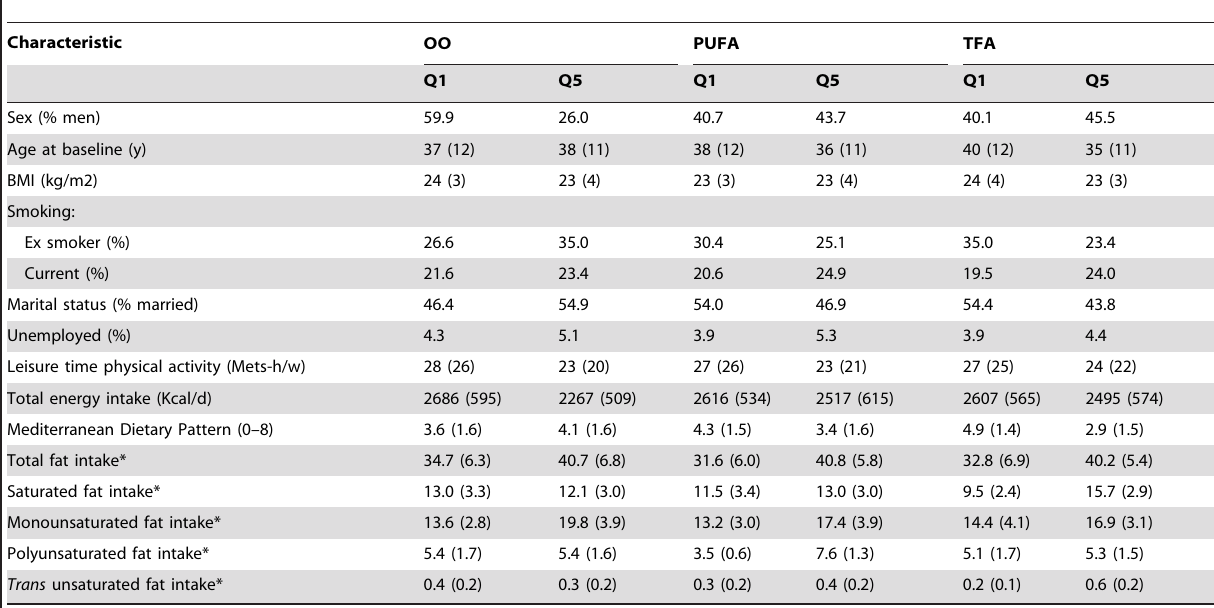
Table 1. Baseline characteristics according to extreme quintiles of olive oil consumption and specific types of fat intake, mean